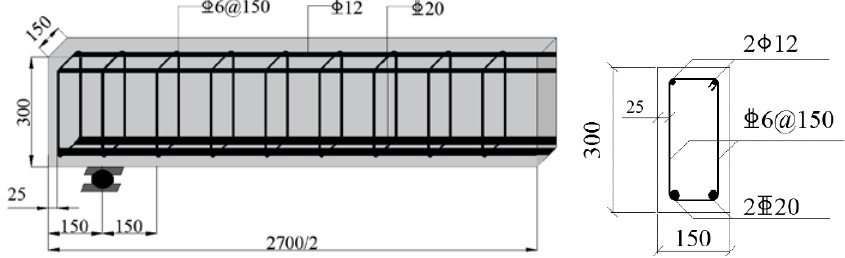
Figure 1. Details of test beams (unit: mm).